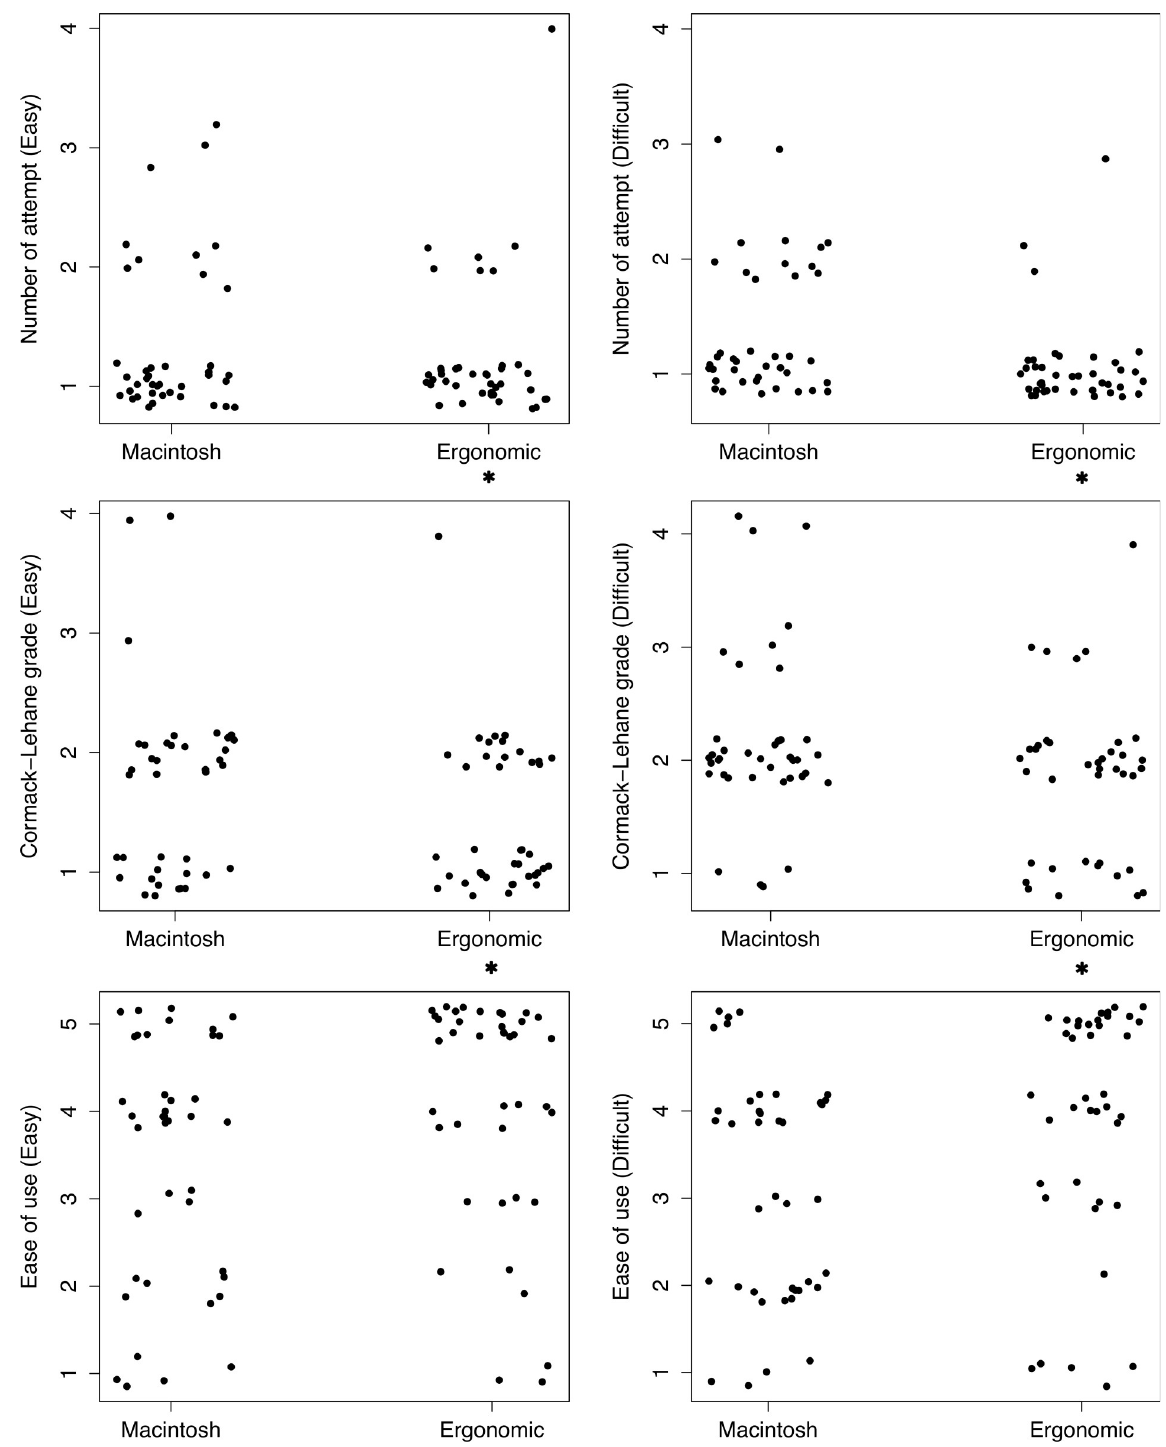
Fig 4. Number of intubation attempts, Cormack-Lehane grade, and ease-of-use scores for intubation groups with and without the ergonomic support grip for easy (left) and difficult (right) airway scenarios; � P < 0.05.